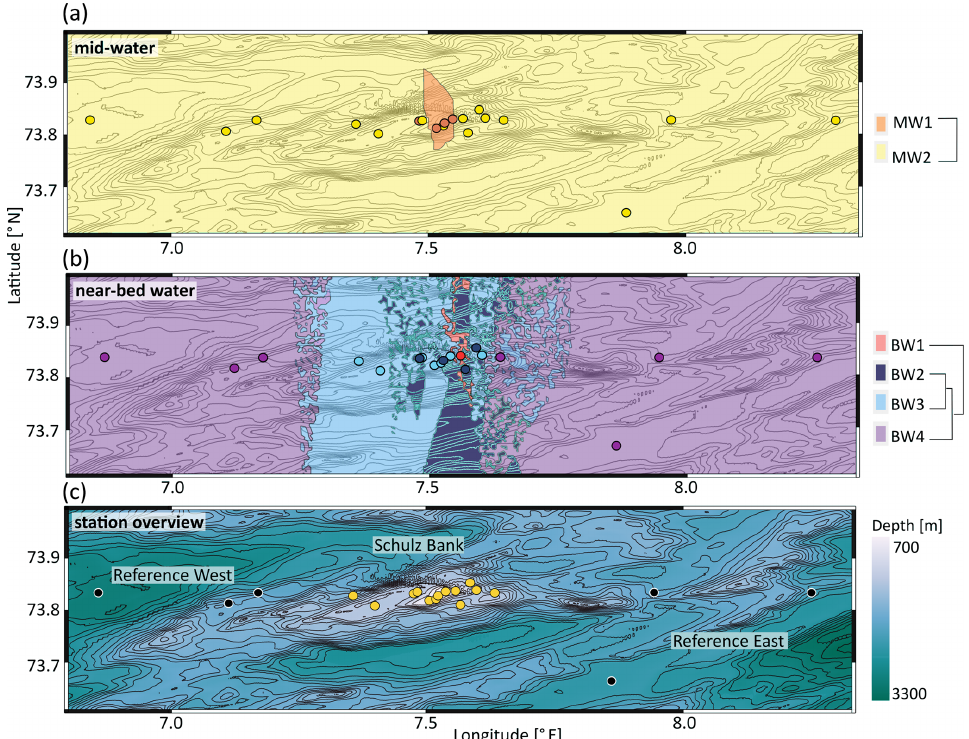
Figure 3. Seawater microbial community structure across Schulz Bank. Contour lines in all three subplots represent the underlying topog- raphy. Colours in panels (a) and (b) represent clusters based on weighted UniFrac distances, where coloured dots indicate stations with in situ sampling and filled areas represent extrapolations based on machine learning. The further away predicted areas are from actual sample points, the higher the associated uncertainty of these predictions is. Panel (a) includes all mid-water samples derived during the CTD tran- sects. Panel (b) includes all near-bed water samples. Here, the degree of cluster similarity can be deduced from the dendrogram to the right of the plot(s). Panel (c) provides an overview of the sampling area, showing the locations of all 19 CTD stations. Stations directly located on the Schulz Bank are coloured yellow, while reference stations (west and east of Schulz Bank) are indicated in black. Colouring in panel (c) was done according to